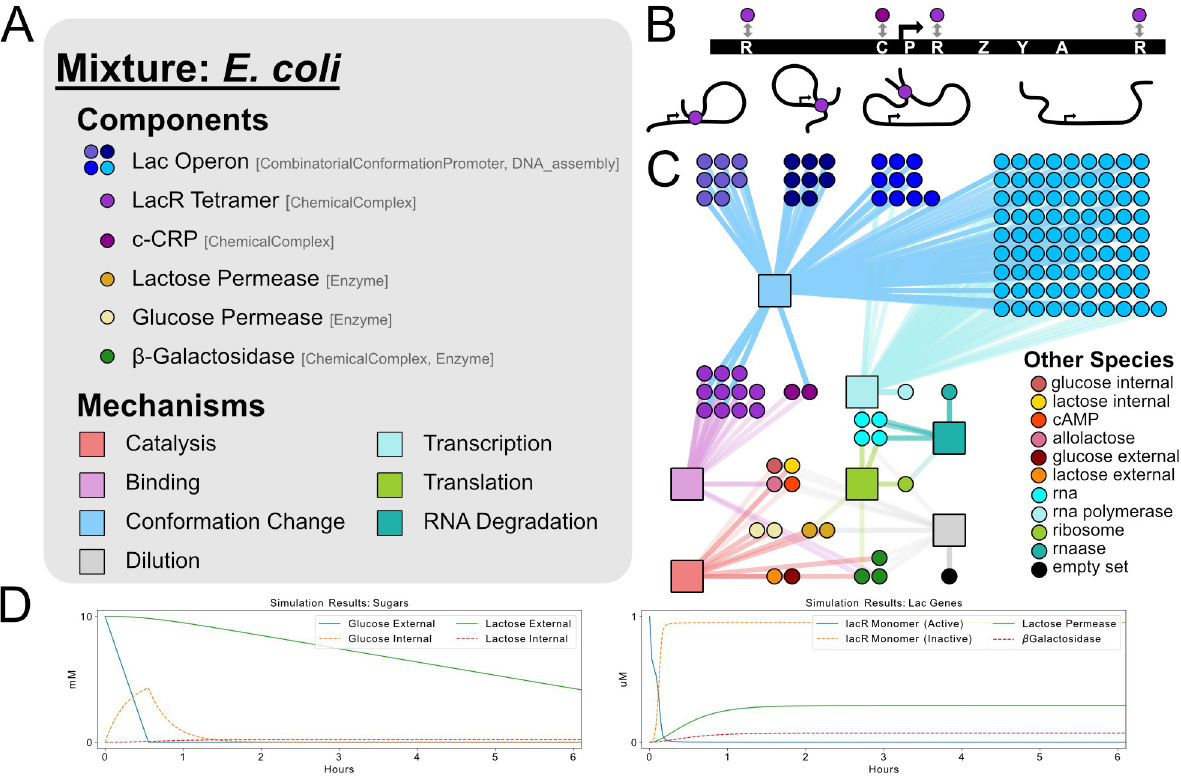
Fig 5. A model of the lac operon compiled using BioCRNpyler specifications with 141 species and 271 reactions using * 50 lines of code. A . A Mixture contains a set of Components and Mechanisms . The Component classes used for each element of the model are shown in brackets. The colored circles show how Components correspond to compiled CRN species in panel C. B . A schematic of the lac operon and the three looped and one open conformation it can take. Each conformation contains a combinatoric number of states based upon the accessible binding sites: R are lac repressor binding sites; C is the activator c-CRP binding site; P is the promoter; and Z, Y, A are the three lac genes. The conformations are placed over clusters of identically colored species corresponding to that conformation in the compiled CRN. C . A graph representation of the compiled CRN. Each circle is a unique chemical species. Square boxes show how chemical species interact via reactions generated by specific Mechanisms . D . Simulated output of the model.